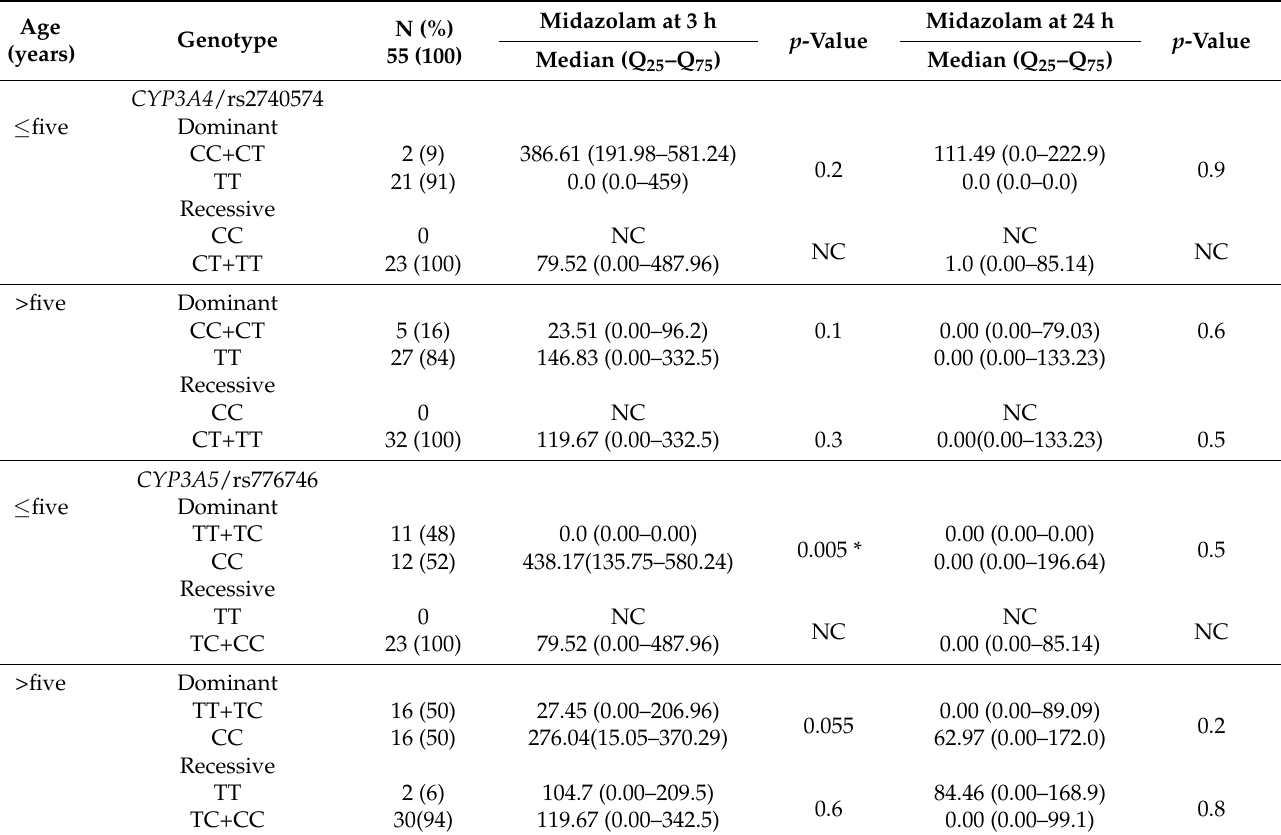
Table 2. Midazolam concentration according to genotype and stratified by